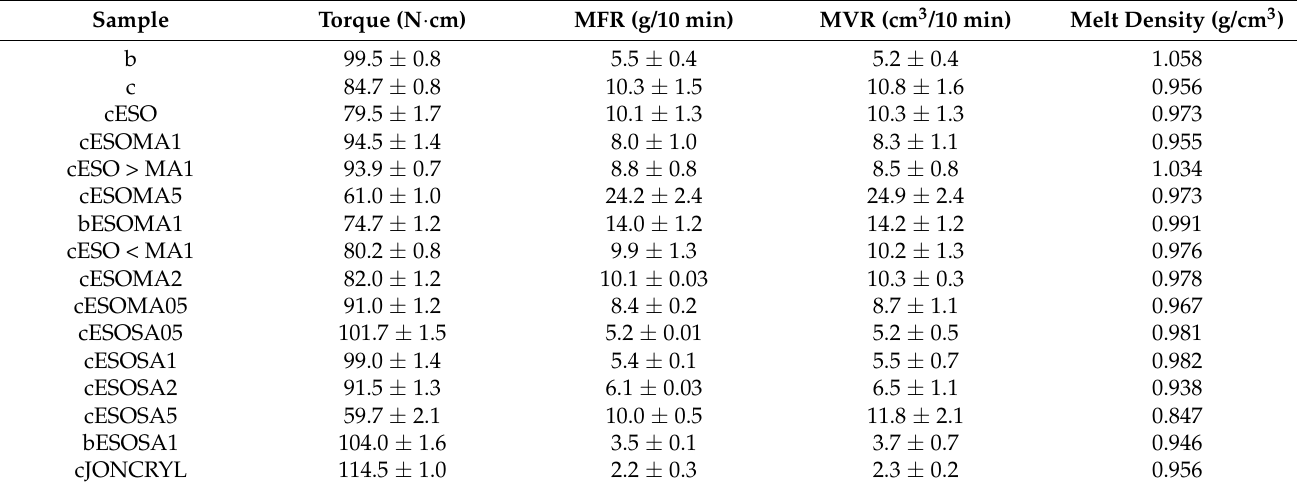
Table 4. Torque and melt flow values of prepared blends and